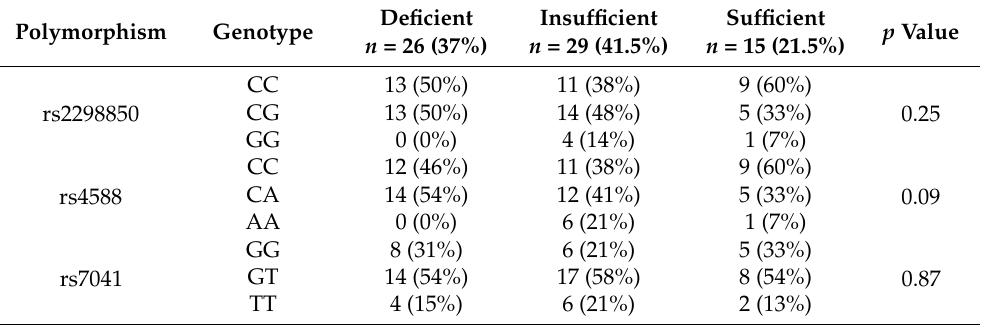
Table 5. Distribution of neonatal vitamin D status according to maternal VDBP genotype polymor- phisms.